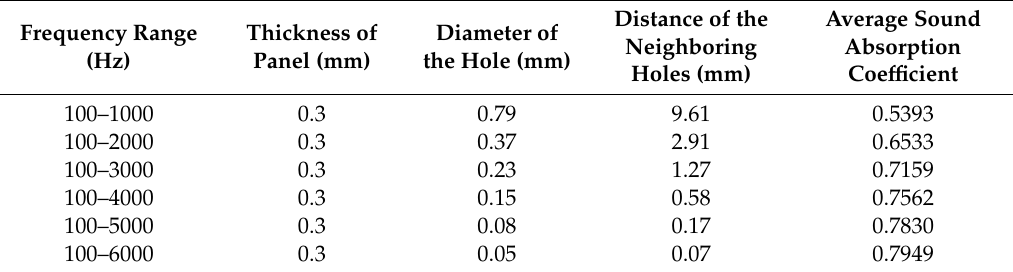
Table 1. Optimal parameters of the microperforated panel for maximum improvement of sound absorption of the porous metal with di ff erent target frequency ranges.